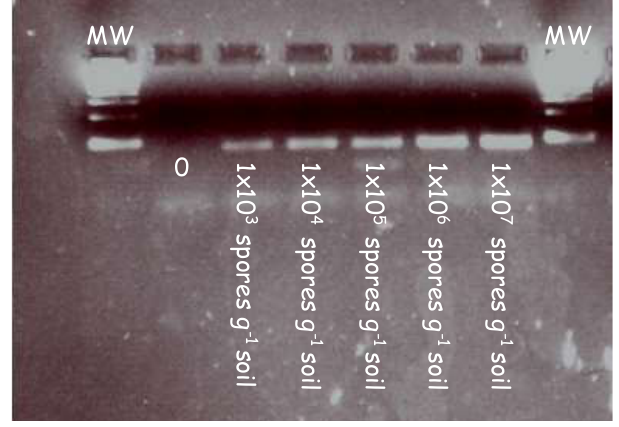
Figure 1. PCR detection of clubroot DNA extracted from samples artificially infested with increasing concentrations of clubroot in soil. Clubroot soil samples were amplified in a series of concentrations using primers targeting the internal transcribed region (ITS). A clear band was detected at each concentration ranging from 1 × 10 3 to 1 × 10 7 . Samples were diluted 1/10 before being loaded into the gel and electrophoresed.